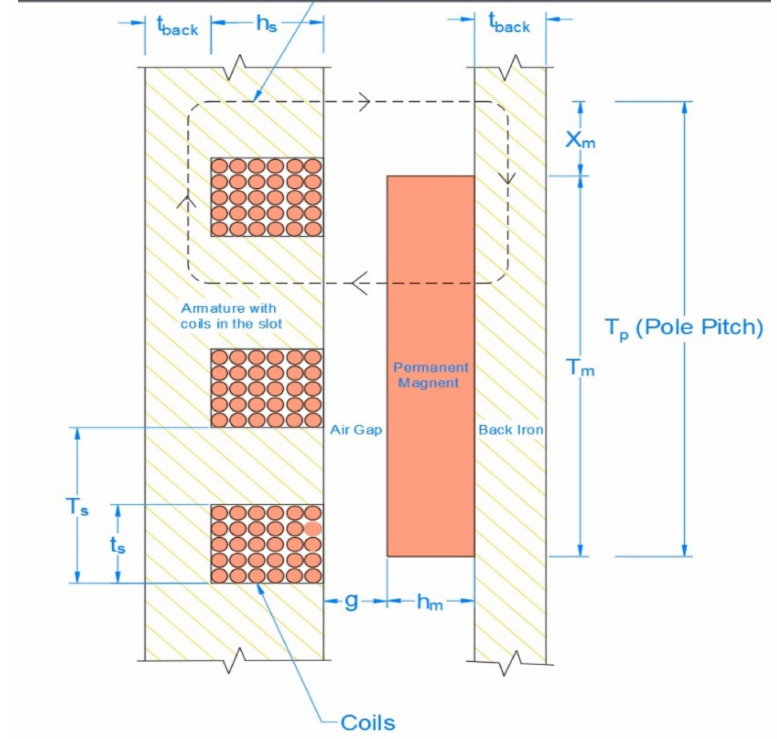
Figure 2. TLSM cross-section